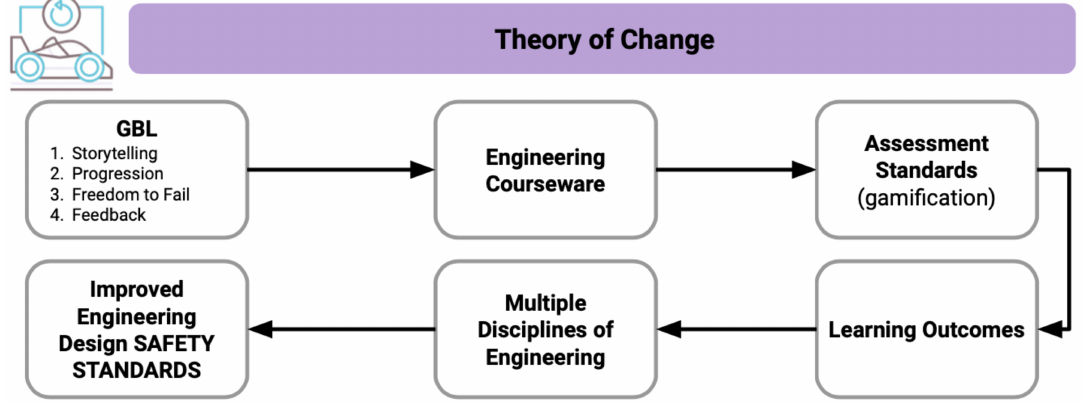
Figure 24. A Theory of Change in engineering education to enhance design and